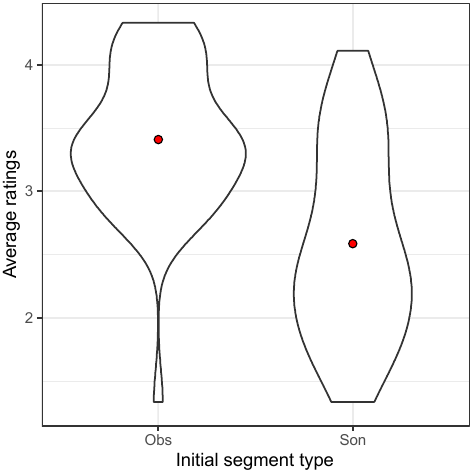
Figure 2. The results of Experiment 2. The x-axis labels are the type of consonants. The plots are violin plots and show the probability distributions of the averaged responses from each speaker. Each transparent blue dot represents an average response from each speaker. The solid red dots represent the grand averages.